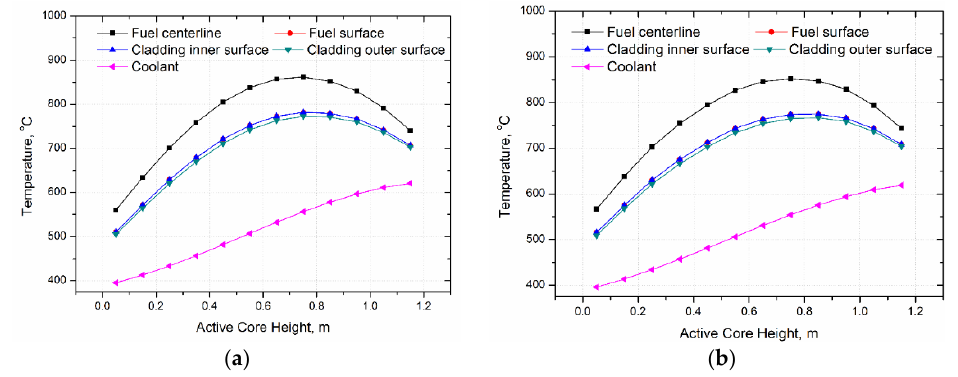
Figure 15. Hot channel temperature distribution of second ‐ half cycle MMR. ( a ) MOL2 of the second ‐ half cycle core; and ( b ) EOL of the second ‐ half cycle core.